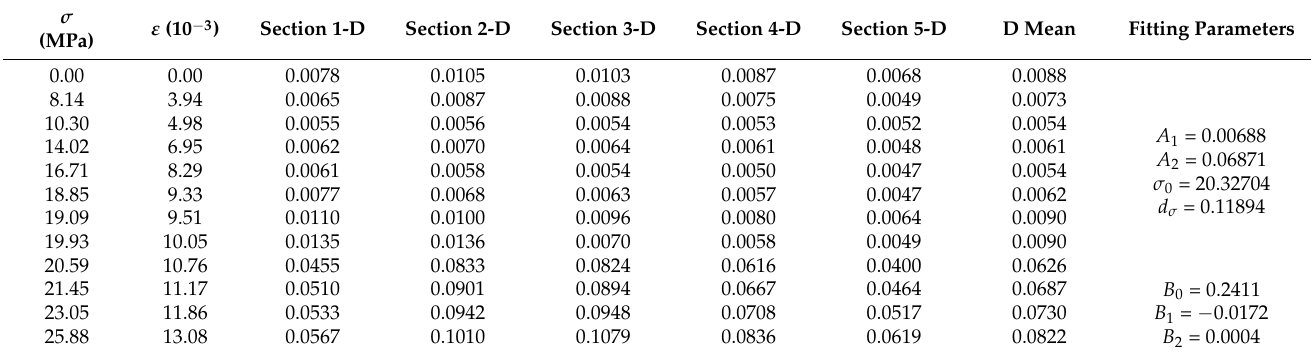
Table 4. List of fitting parameters and results of damage-evolution